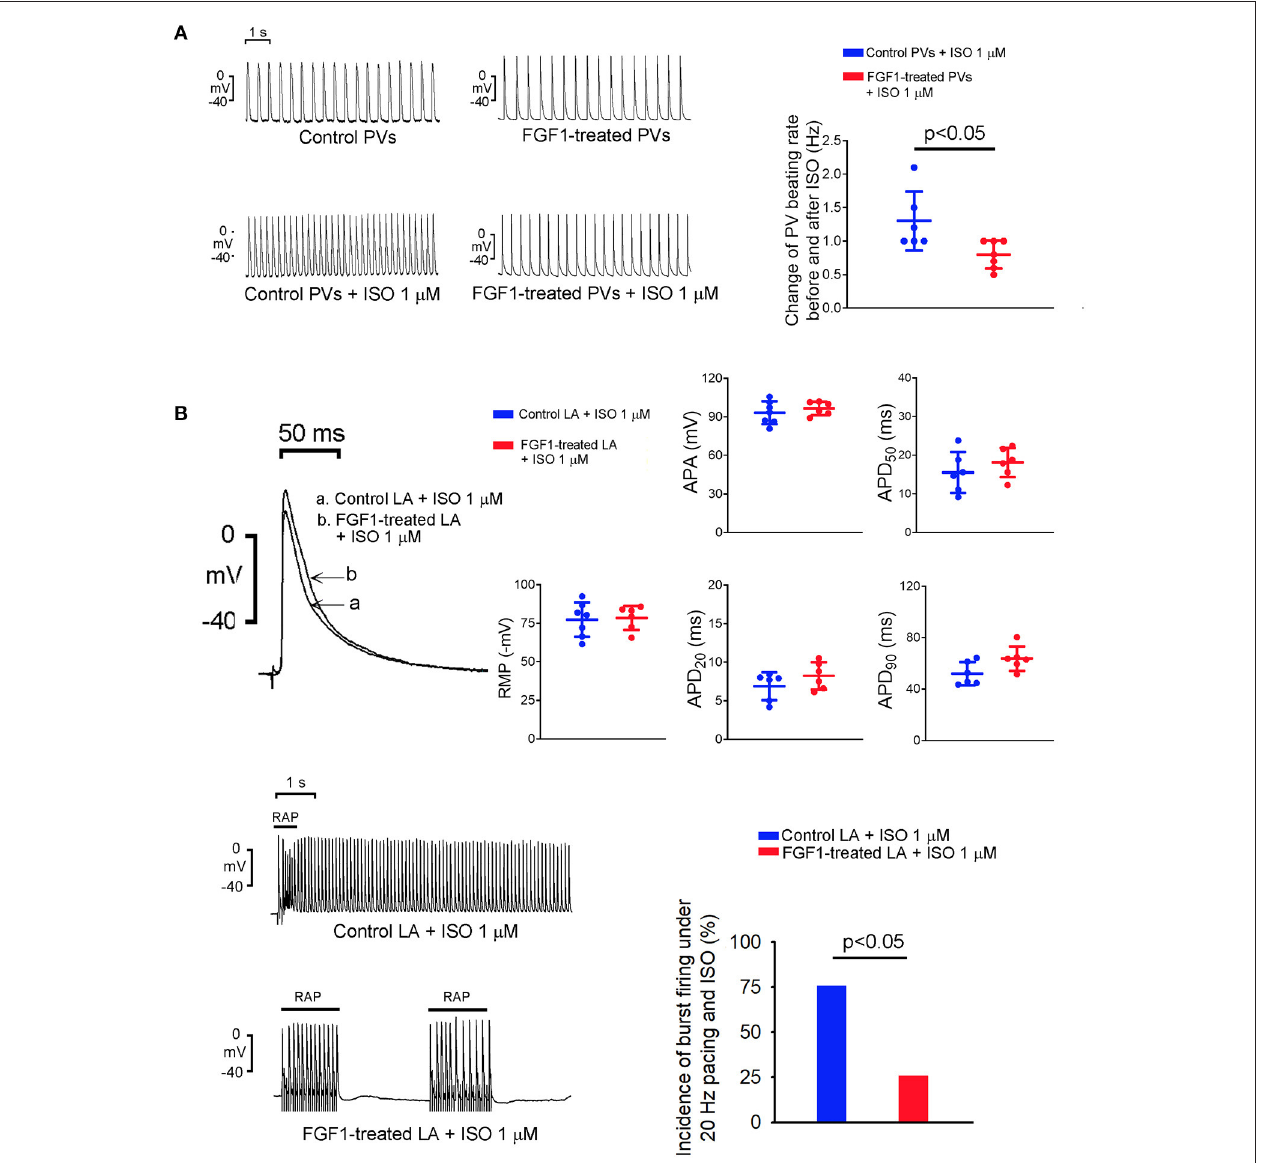
FIGURE 2 | Effect of isoproterenol (ISO) on spontaneous activity of left atrium (LA) and pulmonary vein (PV) tissues with or without fibroblast growth factor 1 (FGF1) treatment. (A) Tracings and scatter plots of ISO (1 µ M)-induced changing PV spontaneous activities in rabbits with ( N = 7) or without ( N = 6) FGF1 (3 µ g/kg) treatment. (B) The upper panel shows the representative tracings and scatter plots of LA action potential morphology under regular pacing (2Hz) in the control and FGF1 (3 µ g/kg)-treated rabbits (both N = 6). The lower panel shows the tracings and incidence of LA burst firing under rapid atrial pacing (20Hz) and ISO (1 µ M) infusion in the control and FGF1 (3 µ g/kg)-treated rabbits (both N = 6).